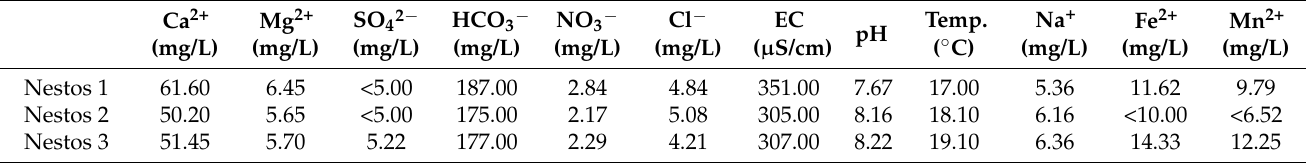
Table 8. Data of the major chemical constituents from the Nestos River (October